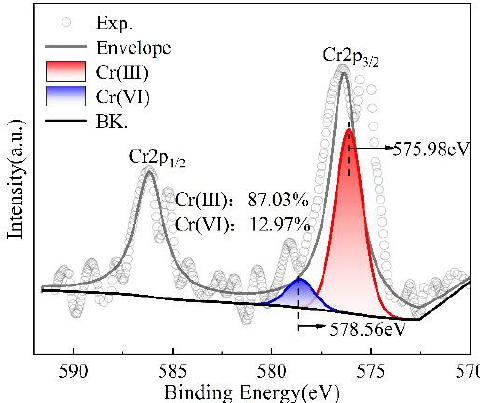
Figure 9. XPS fine spectrum peak splitting results of Cr2p.